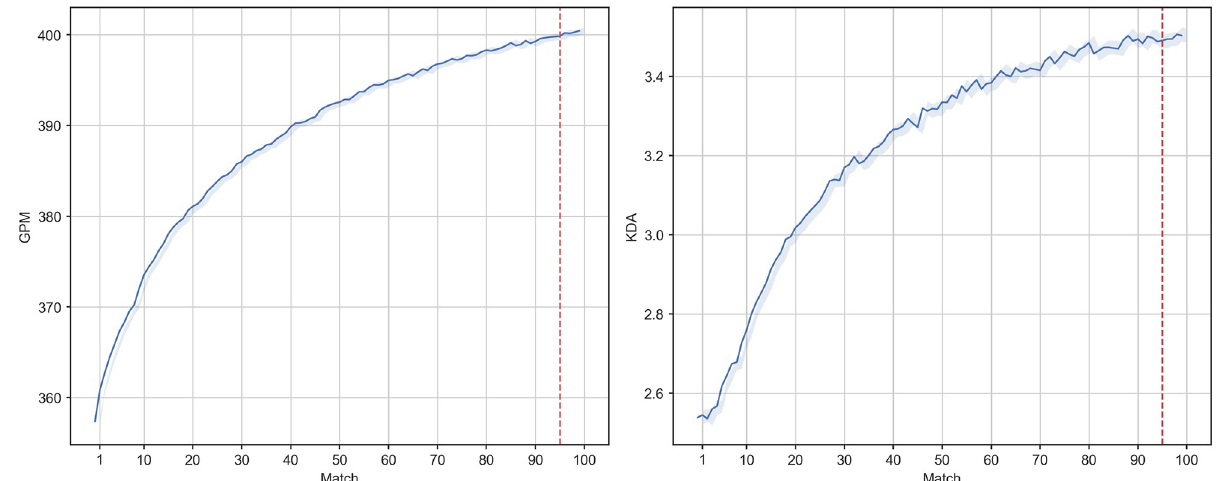
Fig 1. Trajectories of mean GPM (left panel), and KDA (right panel) of all players against match. Shaded regions indicate 95% confidence intervals.